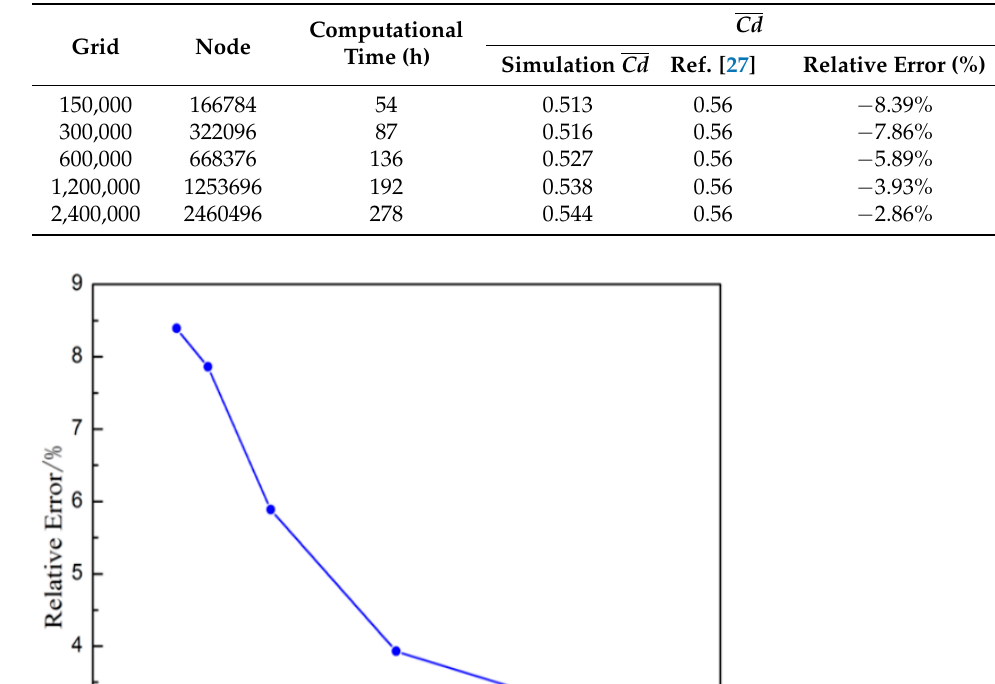
Table 1. Comparison of the computational time, the mean drag coefficient and the relative error.